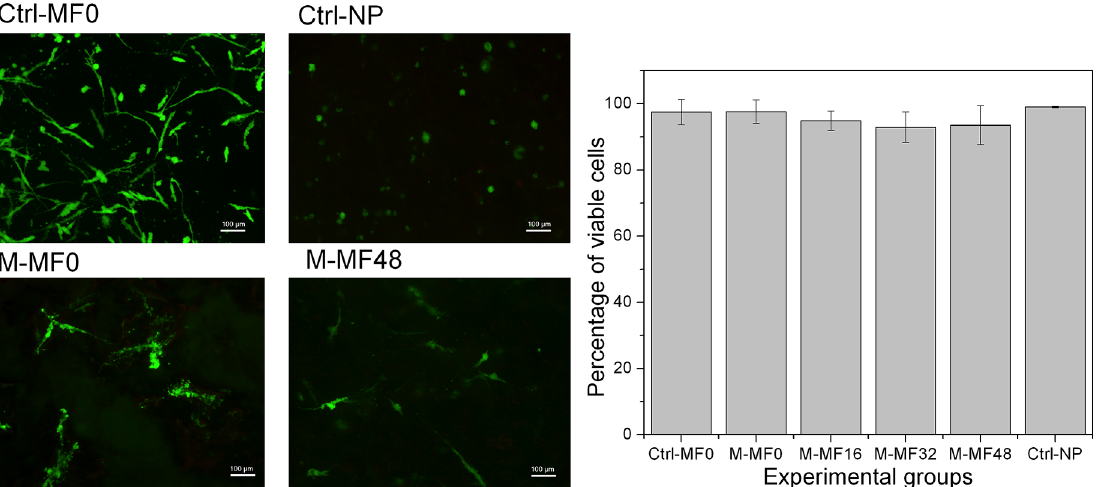
Fig 2. Cell viability tests. Fluorescence microscopy images (scale bar: 100 μ m) representative of each experimental group. Live cells are stained green, and dead cells red. The graph shows the mean values ± standard deviations for live cells from 8 independent experiments for each experimental group. Ctrl- MF0: control (nonmagnetic) tissue substitute without particles, gelled in the absence of a magnetic field; Ctrl-NP: control (nonmagnetic) tissue substitute with nonmagnetic polymer particles; M-MF0: magnetic tissue substitute gelled in the absence of a magnetic field; M-MF16, M-MF32 and M-MF48: magnetic tissue substitutes gelled during application of a 16 kA m -1 , 32 kA m -1 or 48 kA m -1 field, respectively.